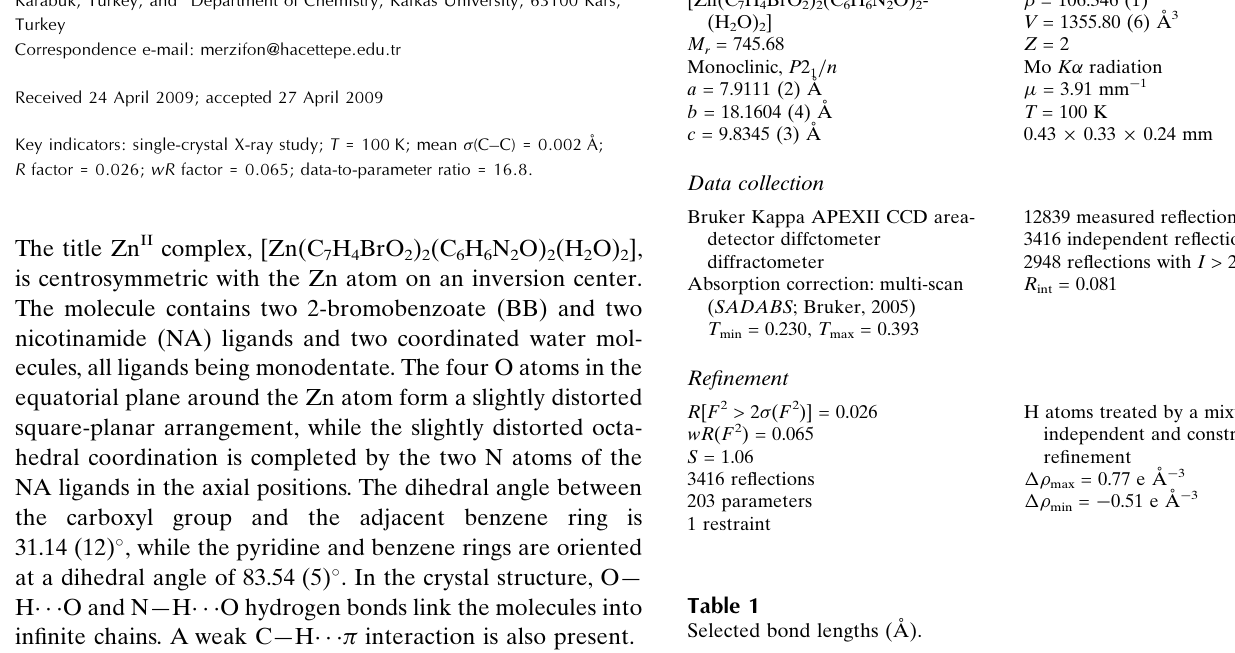
Bruker Kappa APEXII CCD area- detector diffctometer diffractometer Absorption correction: multi-scan